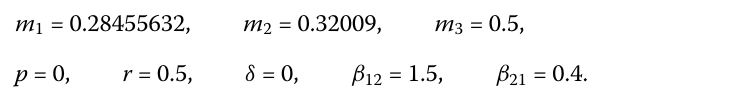
which all have a negative real part. So, the necessary conditions of local stability are veri-